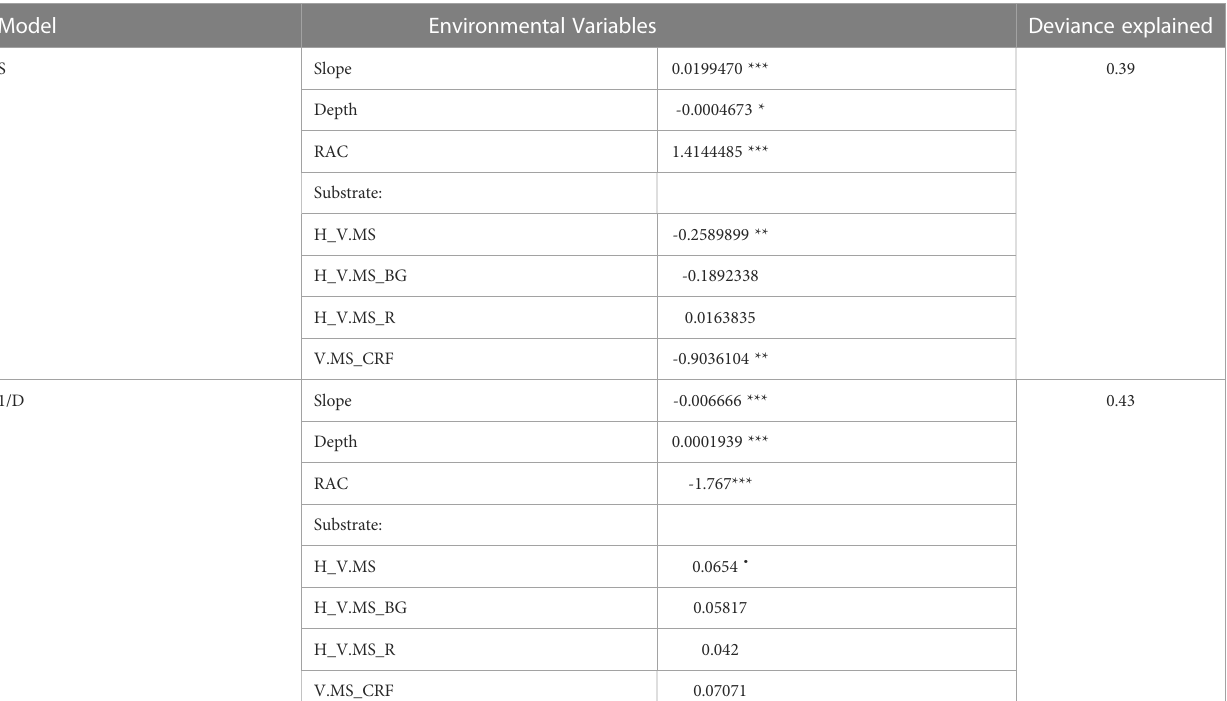
TABLE 4 Results from Generalised Linear Model for species richness and the selected environmental variables.